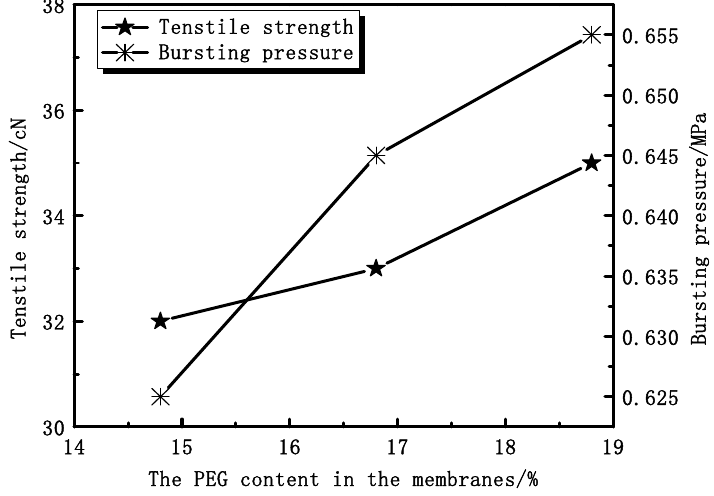
Figure 12. The effect of PEG content on tensile strength and bursting